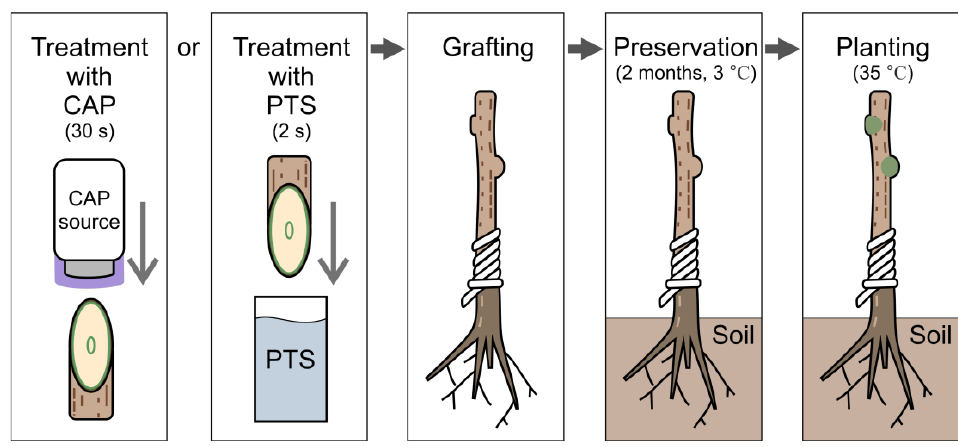
Figure 3. Grafted tree samples’ preparation.